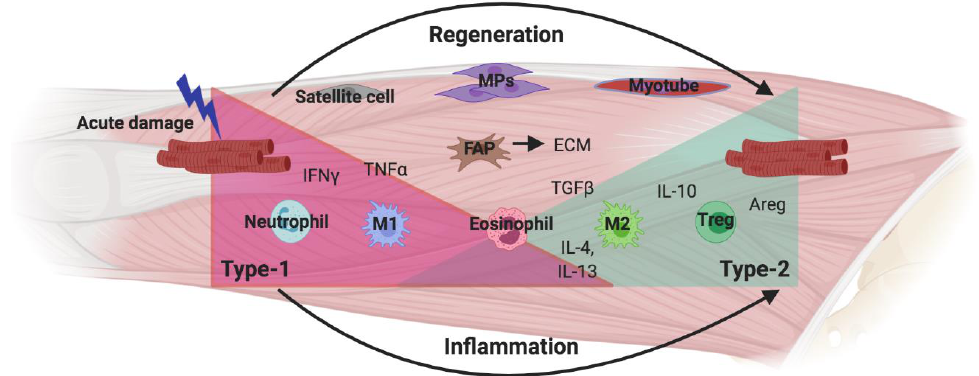
Figure 4. Skeletal muscle regeneration. Acute muscle fiber damage triggers pro-inflammatory